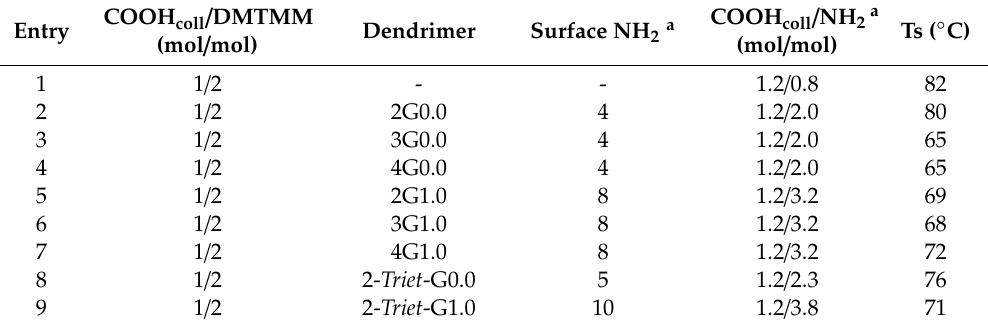
Table 2. E ff ect of PAMAM auxiliaries on the Ts of collagen cross-linked with DMTMM.